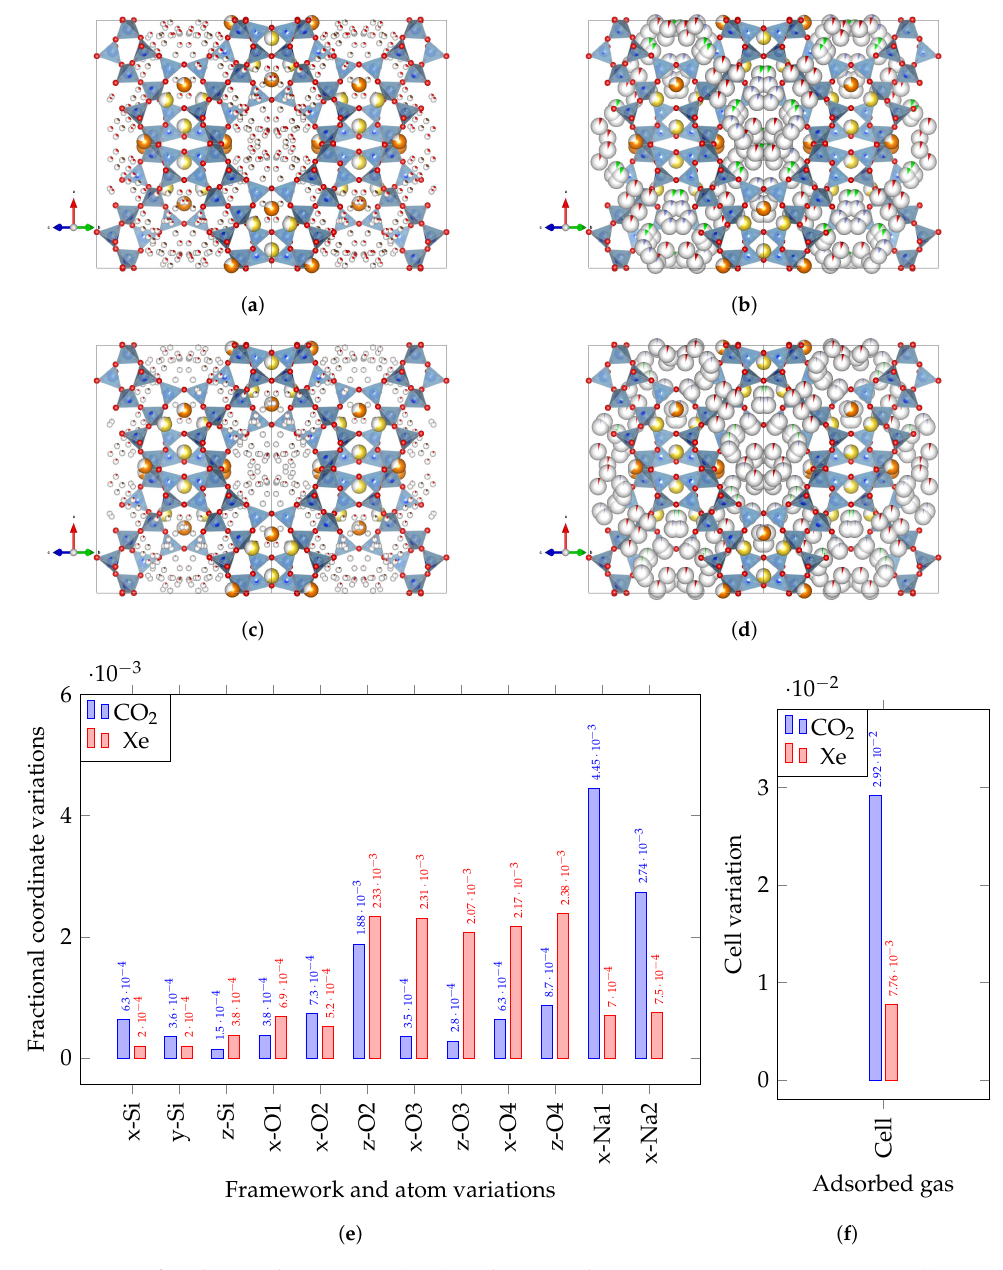
Figure 10. Refined crystal structures ( top ) and more relevant atom-position variations ( bottom ). For atom labelling, refer to Figure 12. ( a ) Y-Zeolite with CO2 at 200 K. ( b ) Y-Zeolite with Xe at 200 K. ( c ) Y-Zeolite with Xe at 300 K. ( d ) Y-Zeolite with CO2 at 300 K. ( e ) Framework and atom variations. ( f ) Cell variation.